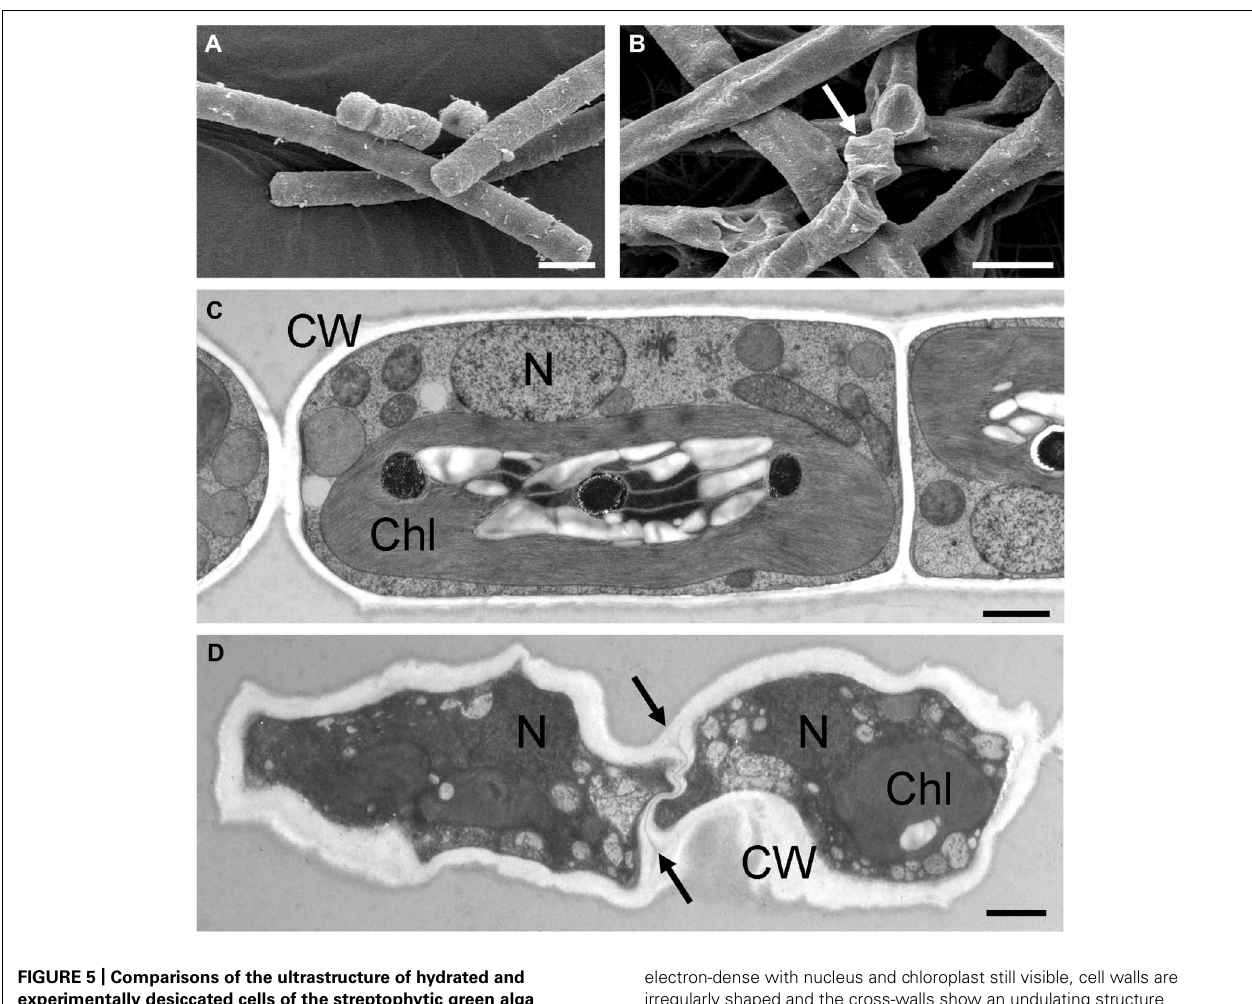
electron-dense with nucleus and chloroplast still visible, cell walls are irregularly shaped and the cross-walls show an undulating structure (arrows). Bars (A,B) 10 μ m, (C,D) 1 μ m. Chl, chloroplast; CW, cell wall; N, nucleus ( A,B reprinted from Holzinger etal., 2011 with permission of the Phycological Society of America; C,D reprinted from Karsten and Holzinger, 2012 with permission from Springer Science and Business